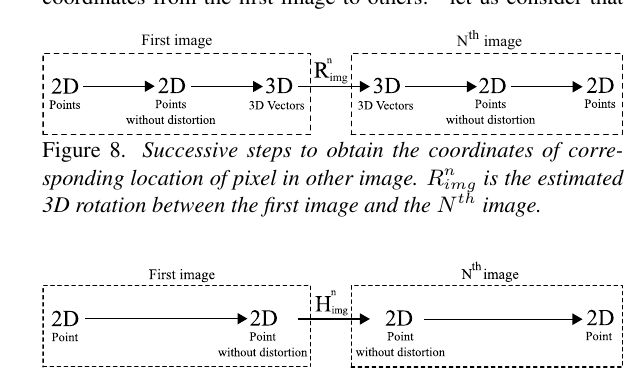
Figure 9. Successive steps to obtain the coordinates of corre- is the estimated sponding location of pixel in other image. H n img 2D homography between the first image and the N th